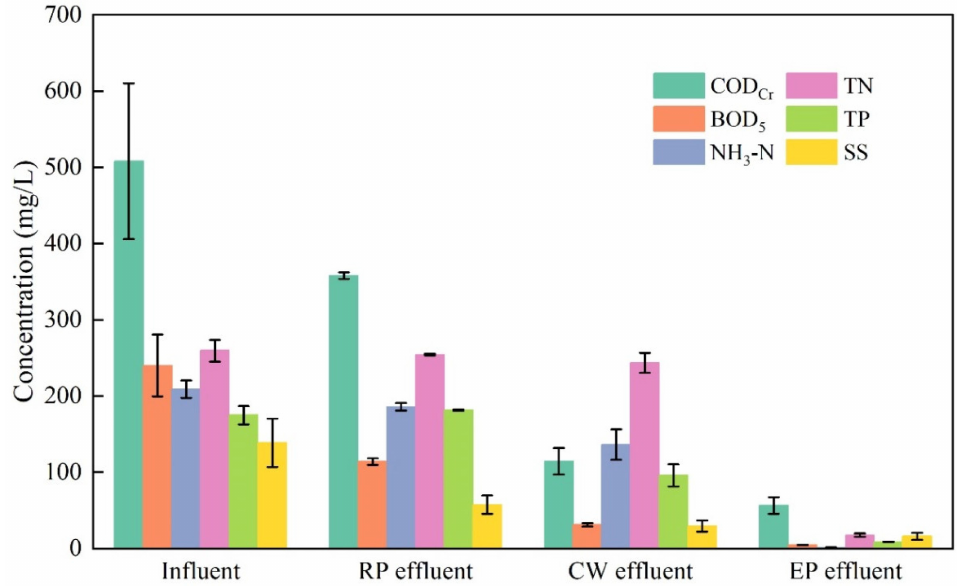
Figure 4. Changes in the concentrations of COD Cr , BOD 5 , NH 3 -N, and SS at different treatment stages (RP: regulation pool; CW: constructed wetland; EP: ecological pond).